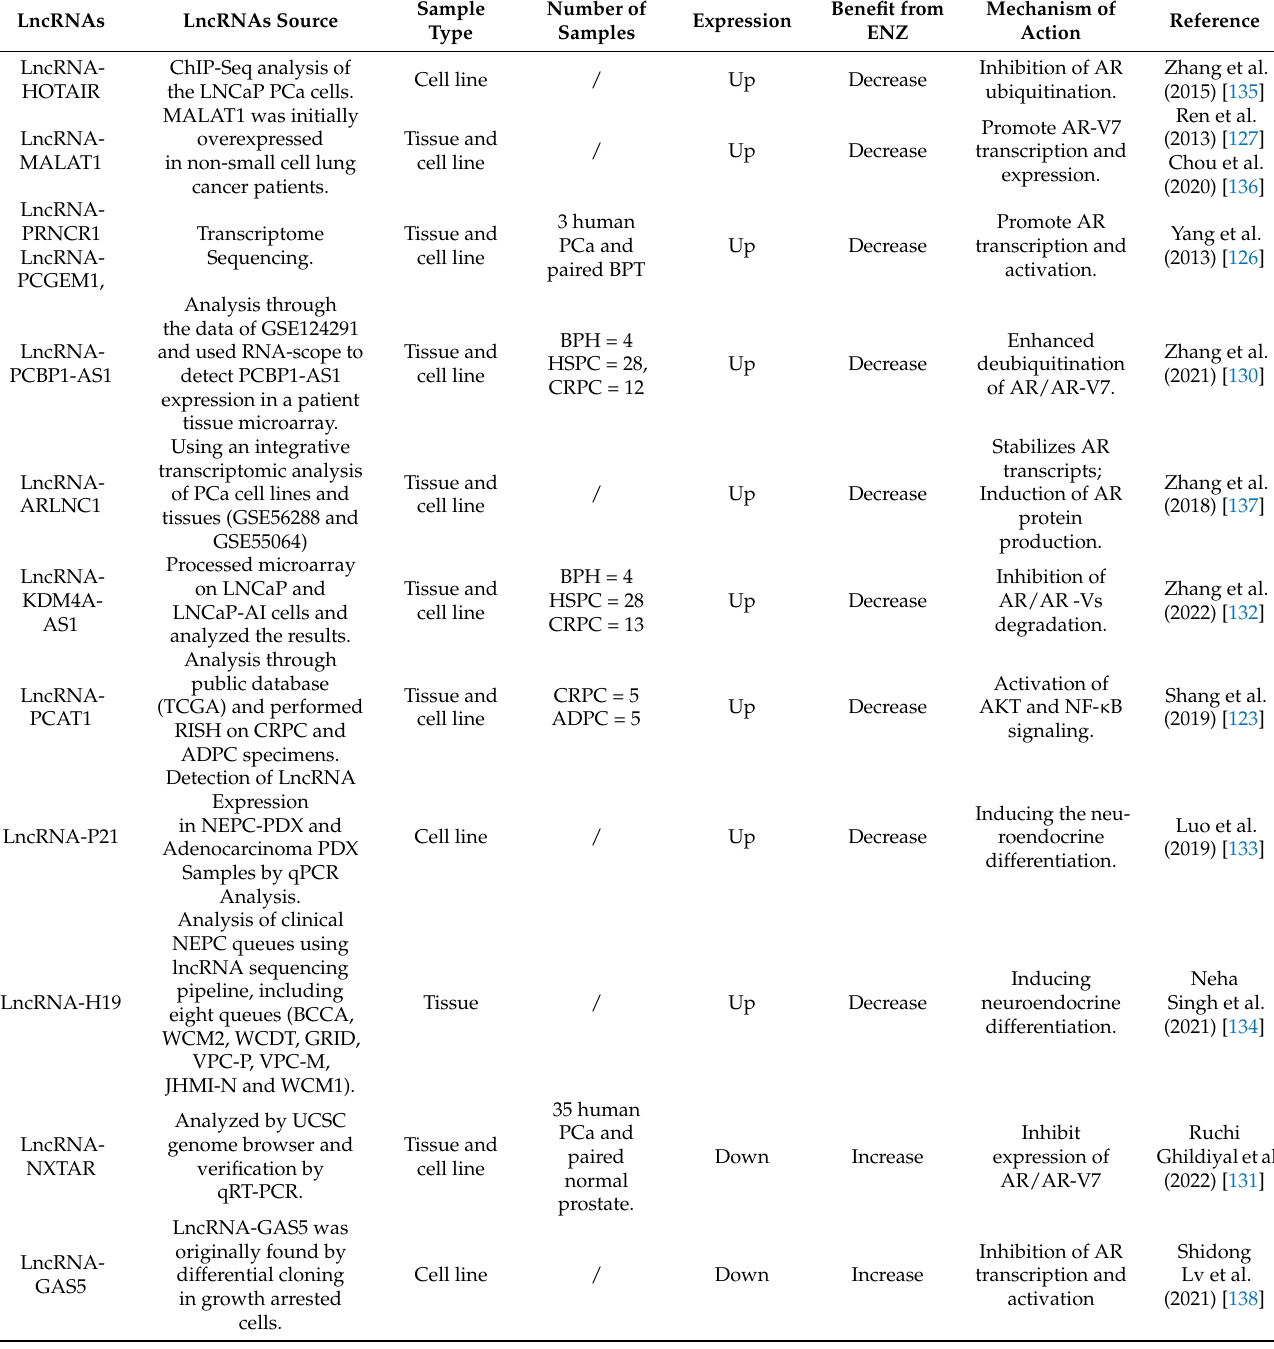
Table 2. The expression of LncRNAs in patients with CRPC affects its benefit from